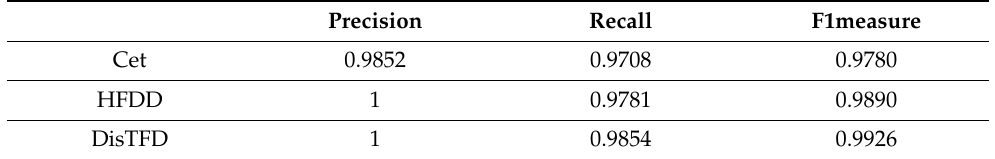
Table 3. Comparison of Cet, HFDD, and DisTFD accuracy on Abalone. Precision